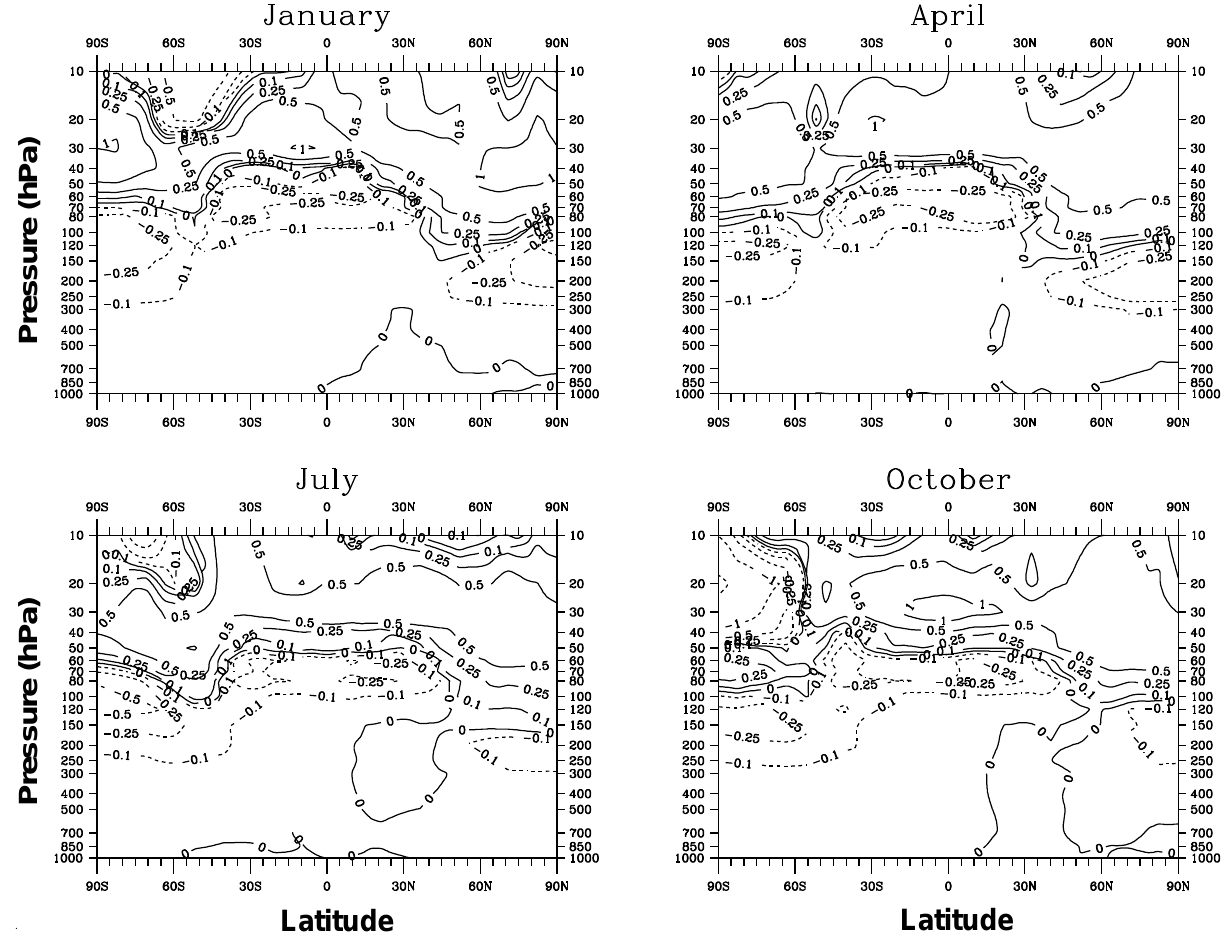
Fig. 12. Difference of modeled and observed (Fortuin and Kelder, 1998) monthly averages of the zonal mean ozone mixing ratios (ppmv) in January, April, July, and October. Positive differences indicate higher ozone concentrations in the